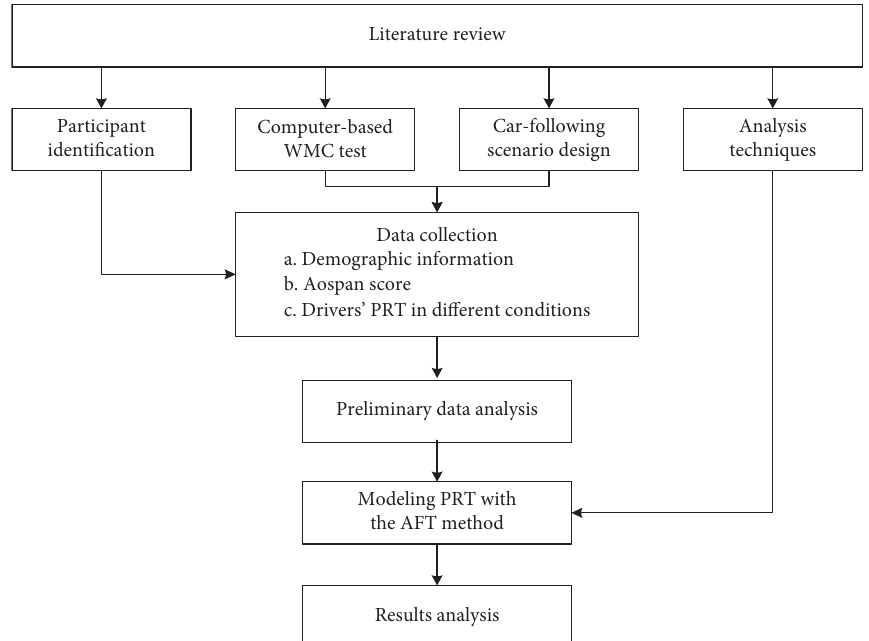
Figure 1: The methodology adopted by the present study.